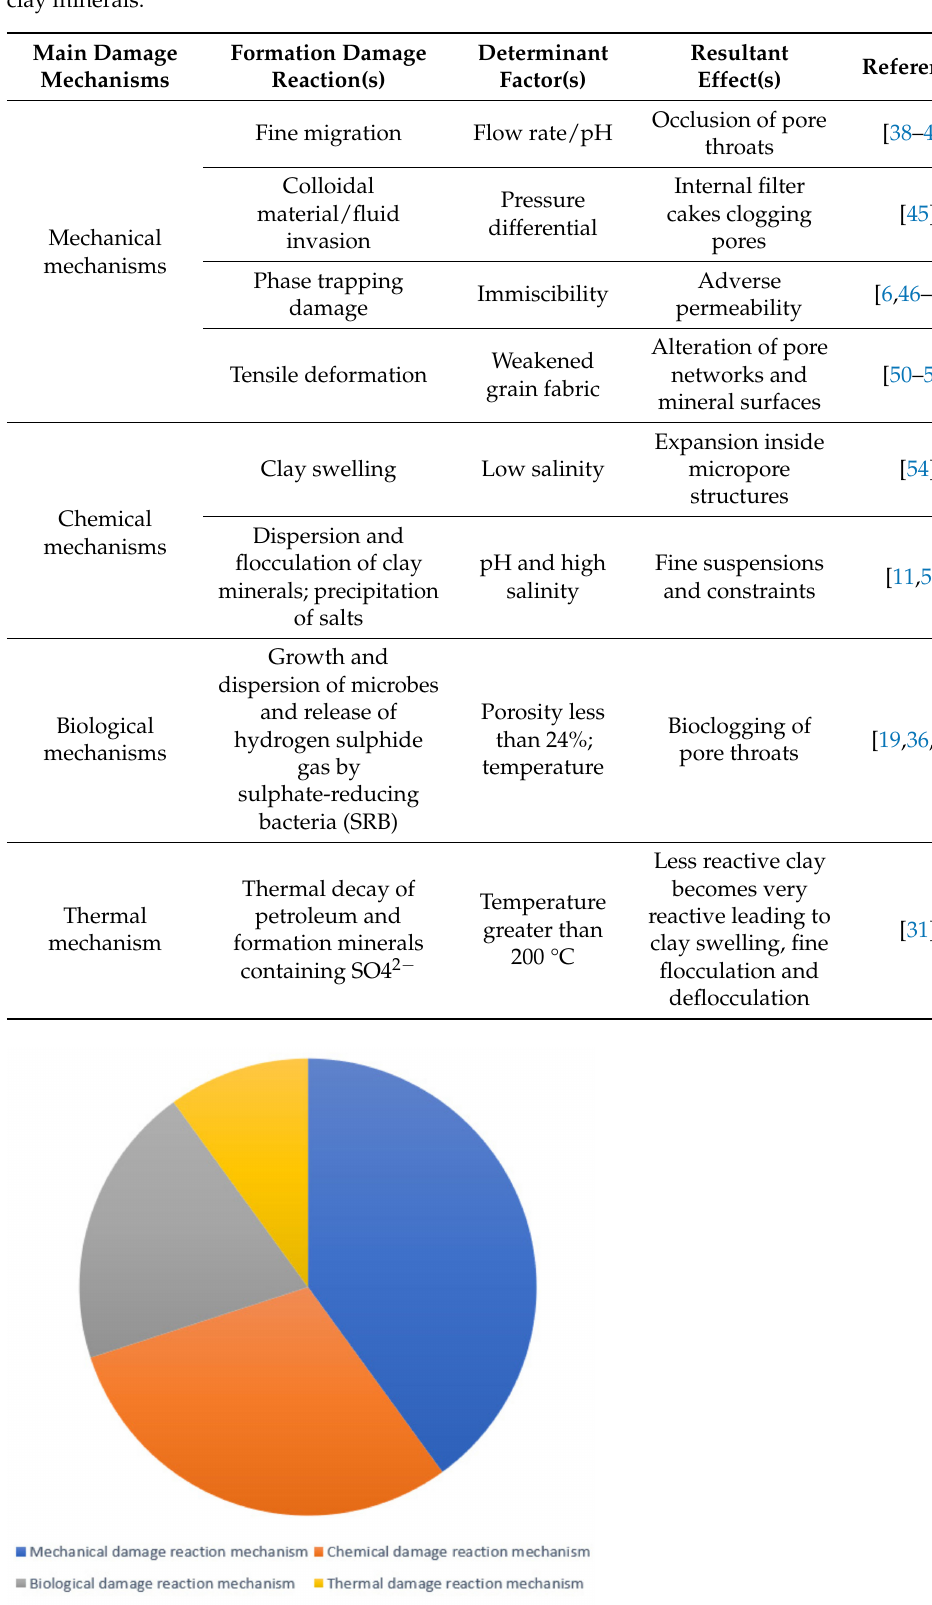
Figure 5. Statistics of formation damage occurrence during drilling operations for sandstone